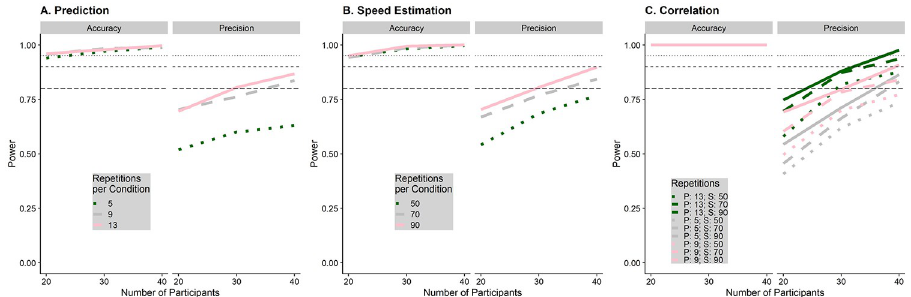
Fig 6. Simulated power for the prediction task (A), the speed estimation task (B) and the correlation between performance in speed estimation and speed prediction (C), separately for the statistical tests referring to biases (accuracy) and variability (precision). The number of participants for which we simulated power is on the x axis, while the number of trials for each task is coded with different shades of green and line types. The horizontal lines indicate a power level of 0.8, 0.9 and 0.95